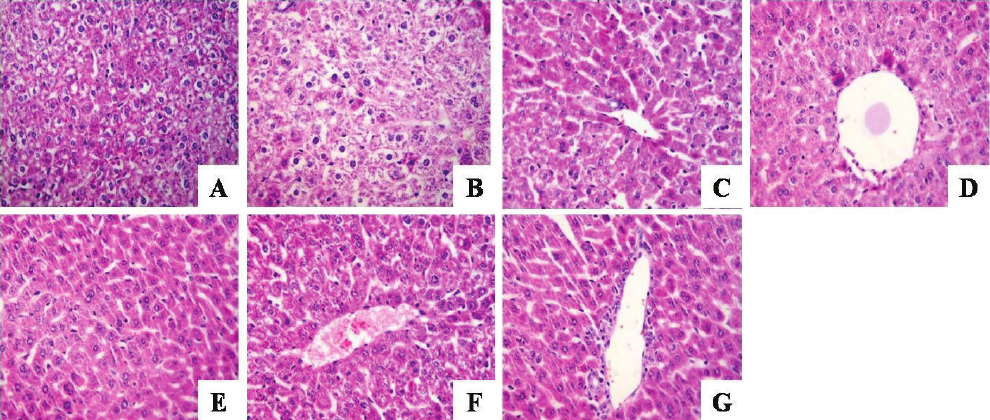
FIGURE 4 – Histopathology of liver tissue of the mice in different groups (×200), with eight mice in each group. (A) Normal control group. (B) Irradiated control group. (C) Amifostine-treated irradiated group. (D) SOD-treated irradiated group. (E) High dosage of Hep-SOD-treated irradiated group. (F) Medium dosage of Hep-SOD-treated irradiated group. (G) Low dosage of Hep- SOD-treated irradiated